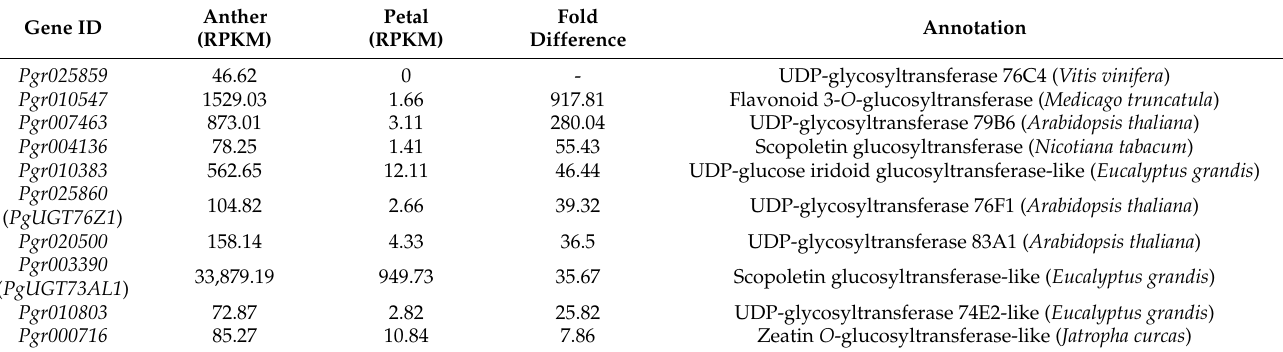
Table 1. UGTs that showed higher expression in anthers than petals of pomegranate flowers in the transcriptome analysis.